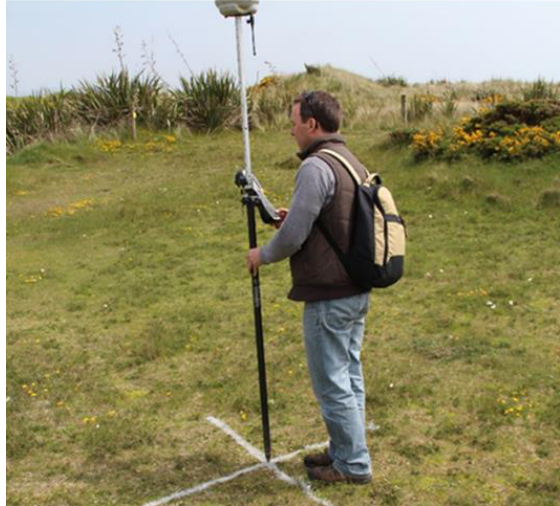
Figure 3. GCPs set on site for RPAS surveying.